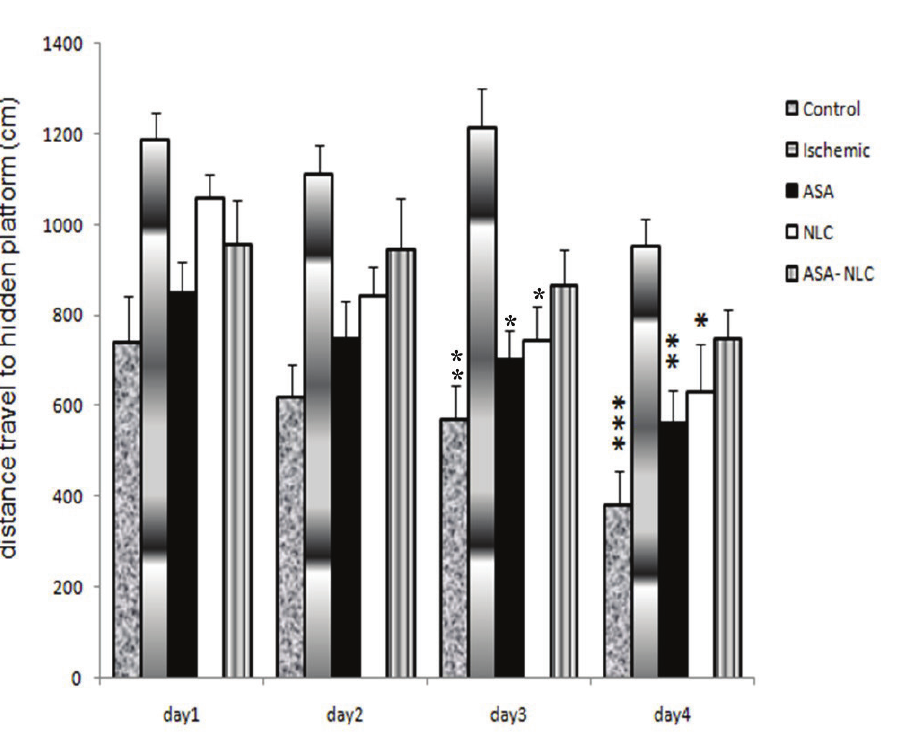
Figure 1: Spatial learning performance in the different groups: The distance traveled to locate the hidden platform.“*”indicates a significant difference when compared with the ischemic group. Day-to-day comparison between groups were analyzed using the “Repeated measures ANOVA”. Distance traveled in the ischemic group was significantly higher than the control group. This parameter was significantly reduced in ASA and NLC groups in comparison to the ischemic group. Co- administration of aspirin and neural-like cells did not significantly improve the results compared with the ischemic group. *, p ≤ 0.05; **, p ≤ 0.01; ***, p ≤